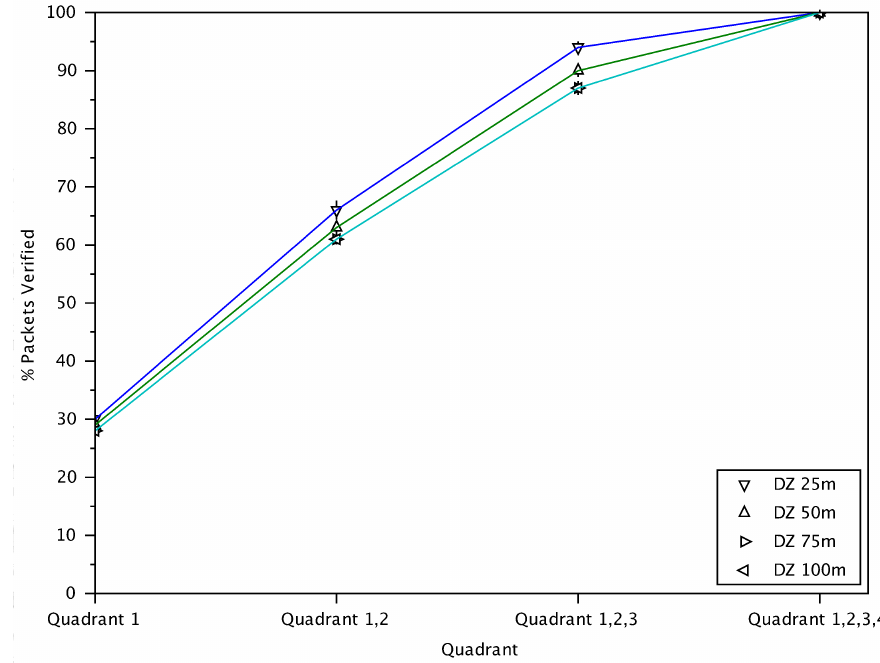
Figure 7. The cumulative percentage of verified messages from different quadrants for RTZ with different danger-zone